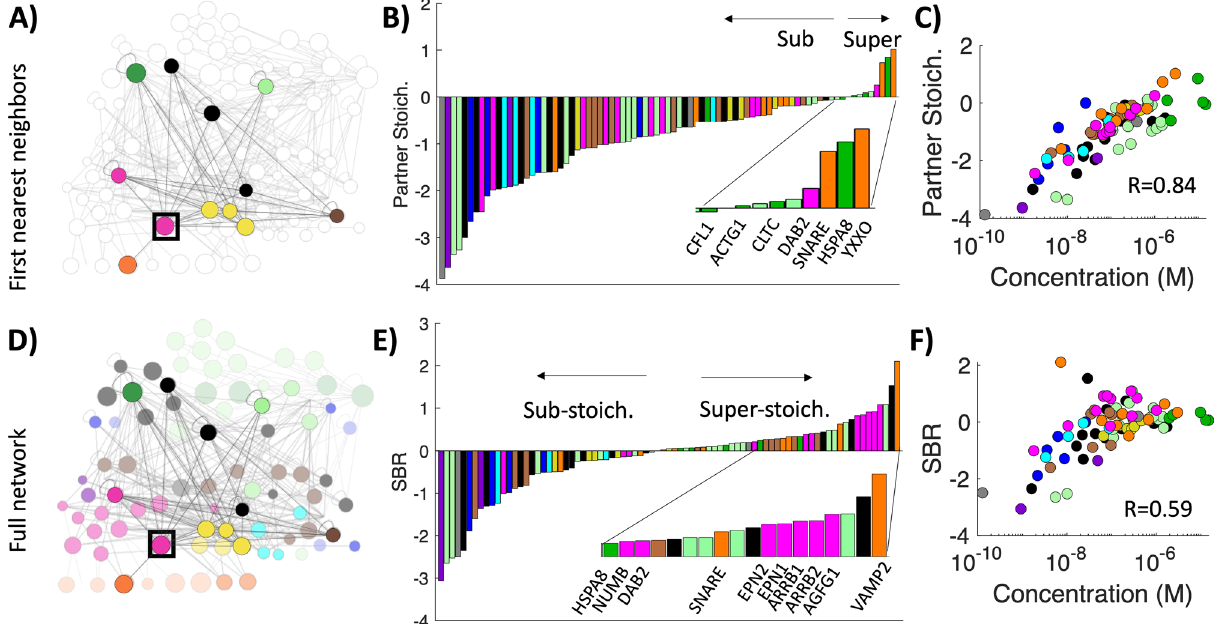
Figure 5. Stoichiometry of each protein to its direct binding partners, or to the full network, shows distinct patterns for highly abundant proteins. ( A ) A simple model of balance compares a protein only to its immediate binding partners or nearest neighbors, shown here for cargo adaptor DAB2. Node size is scaled to log10(abundance). ( B ) Competition for single interfaces results in most proteins being sub-stoichiometric, or without sufficient supply to meet partner demands. Stoichiometry is on a log10 scale, each integer thus indicating orders-of-magnitude differences between experimentally observed copies (here for HeLa cells 2,3 ) and balanced copies. ( C ) Because only nearest neighbors are considered, partner stoichiometry correlates strongly with concentration, with abundant proteins most likely super-stoichiometric. ( D ) With the stoichiometric balance method, not only first neighbors (dark nodes) but second (faded) and beyond (more faded) neighbors contribute to overall stoichiometry through their competition. ( E ) With the SBR, many sub-stoichiometric proteins are similar to the simpler balance method. However, super-stoichiometric proteins now include most of the cargo adaptor proteins (pink), which are all competing with one another to bind AP-2 and clathrin. ( F ) The SBR has weaker correlation with concentration, as proteins with lower abundance are also super-stoichiometric. The cargo VAMP2 has low abundance but is super-stoichiometric, due to competing with the abundant class of SNARE_class proteins for